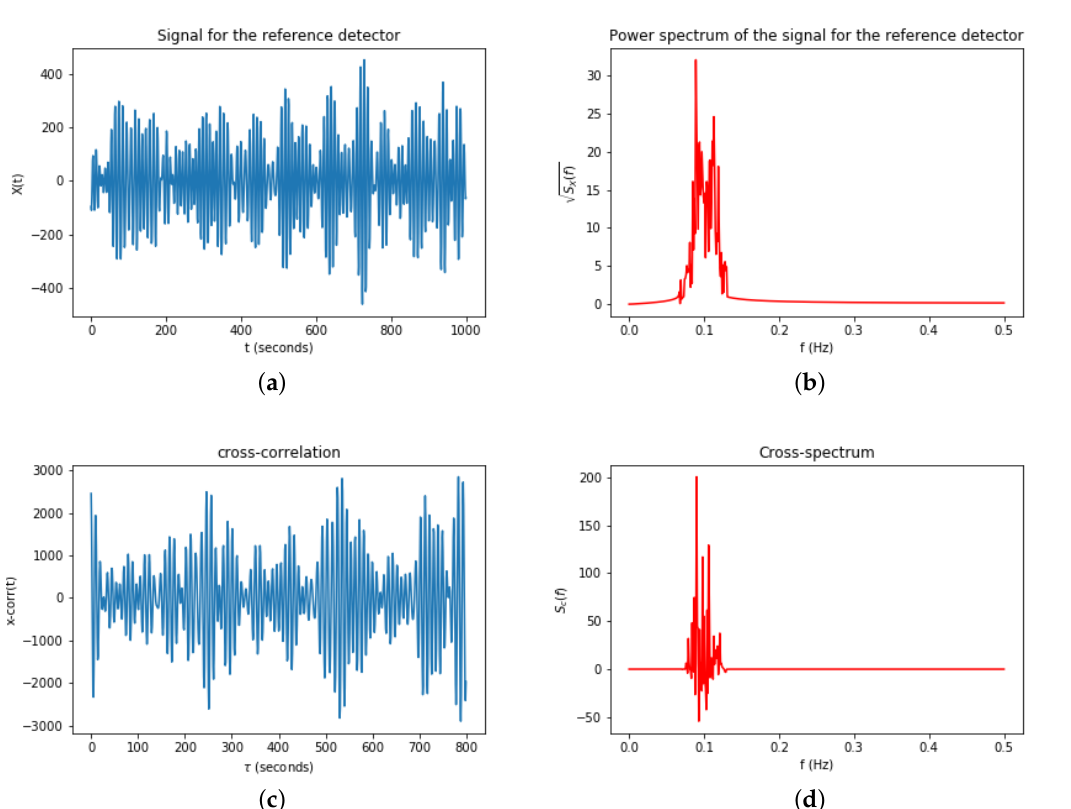
Figure 4. ( a ) Signal at the reference detector (clock); ( b ) Its spectrum; ( c ) Cross-correlator for two signals (two pairs of atomic clocks); ( d )